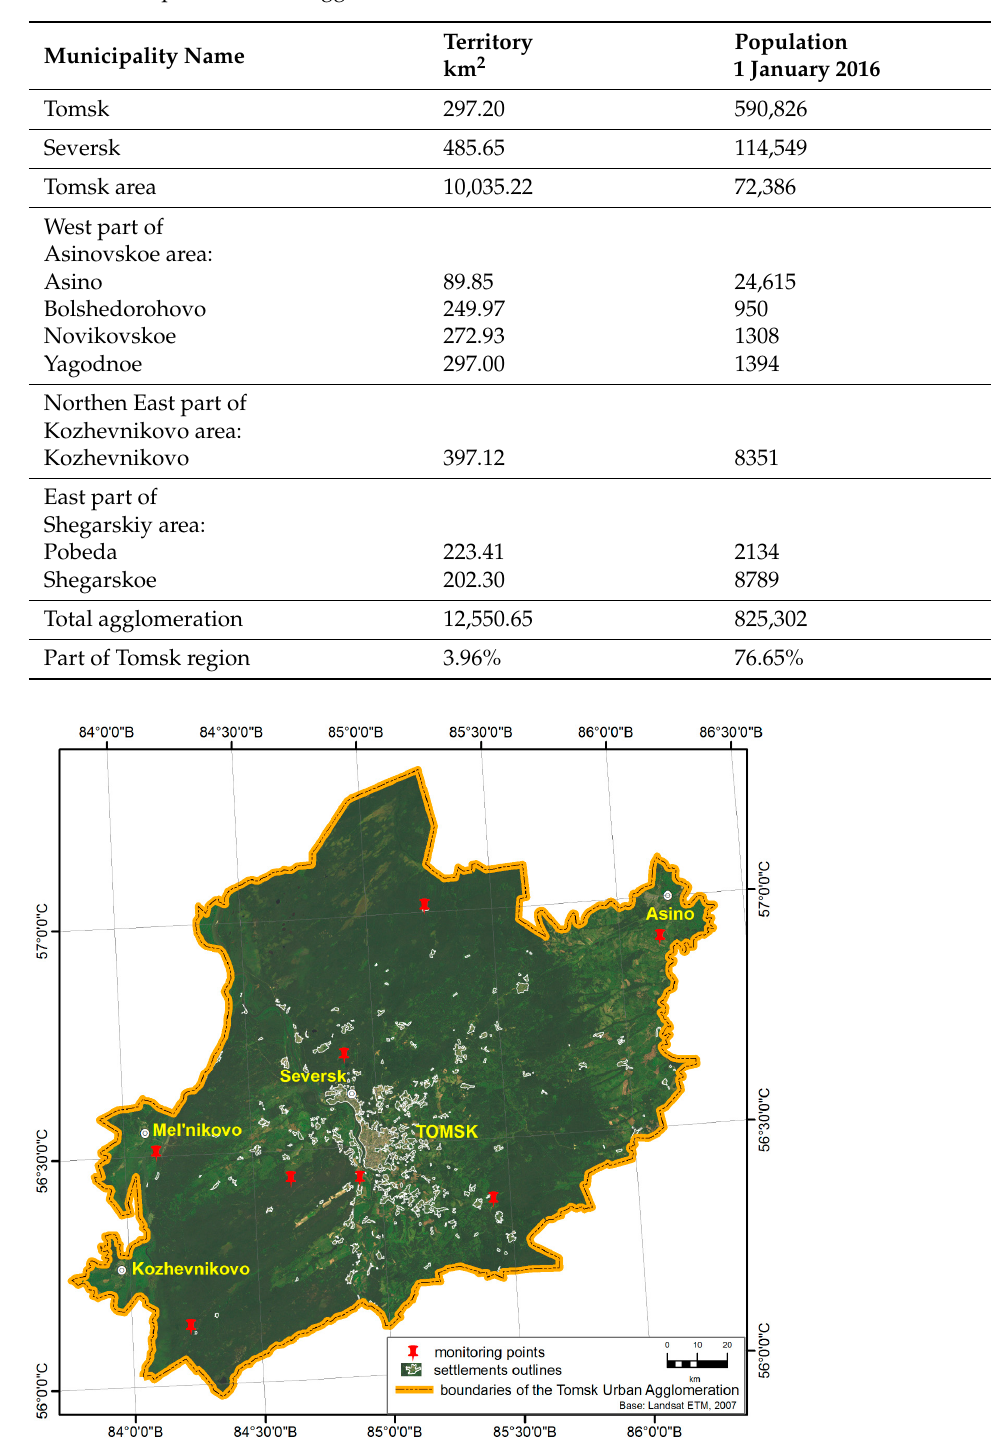
Table 1. Composition of the agglomeration.